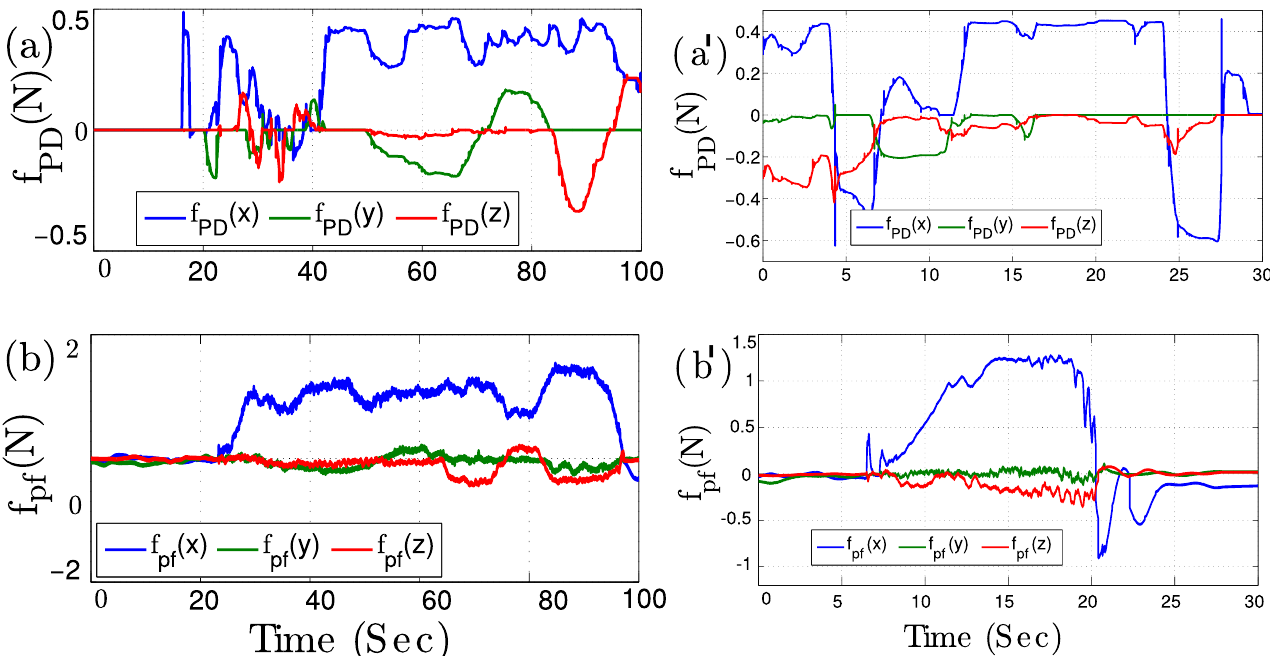
Figure 10. Stationary ( left ) and movable ( right ) object experiments: ( a , a’ ) spring–damper force brings back the master device’s handle to the center of its workspace, ( b , b’ ) the haptic feedback f pf that renders the applied force to the object in contact and position error in free